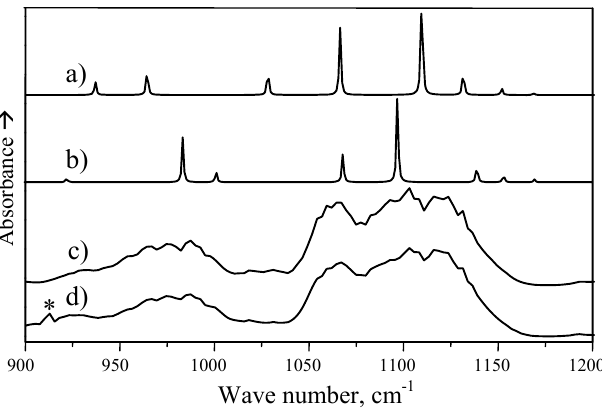
Fig. 7 IR absorption spectra of 1-butene SOZ in frequency range of the ring vibra- tions: a) theoretically (B3LYP 6-311++G (3df, 3pd)) calculated spectrum of 1- butene SOZ gauche conformer; b) theoretically calculated spectrum of 1-butene SOZ anti con- former, c) experimental spectrum of gaseous sample at 240 K, d) experimental spectrum of gaseous sample at 295 K. ∗ - denotes 1-butene band.